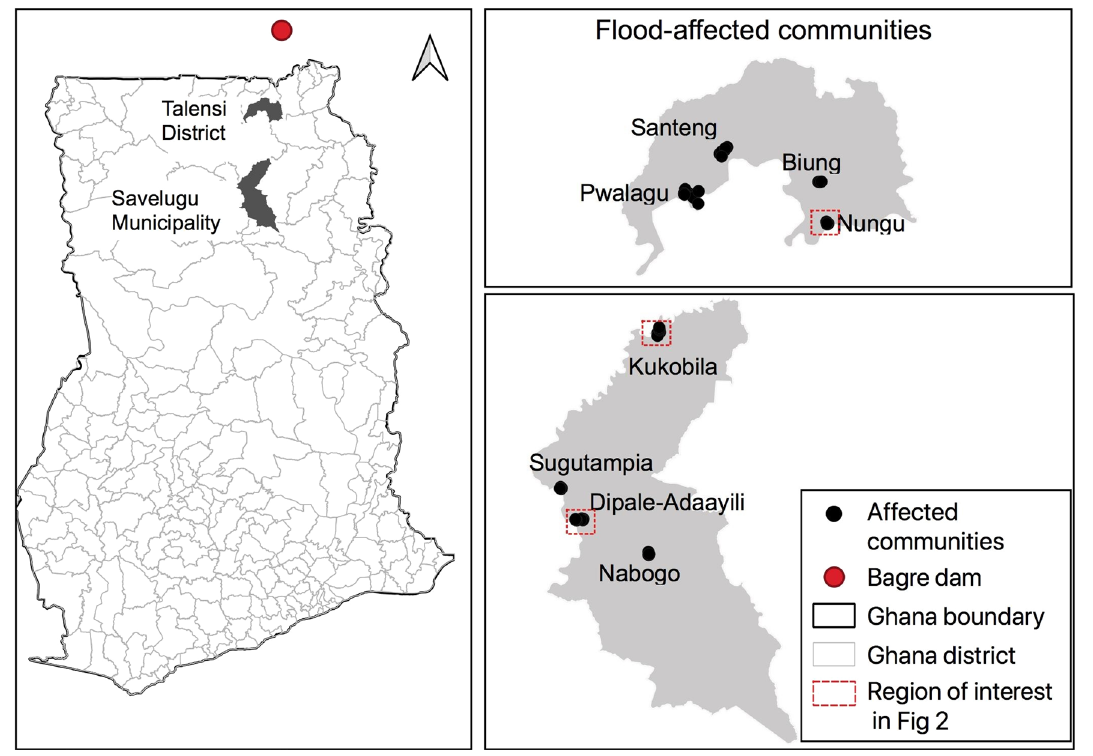
Fig. 1 Maps showing location of Bagre Dam and Talensi and Savelugu Municipality districts in northern